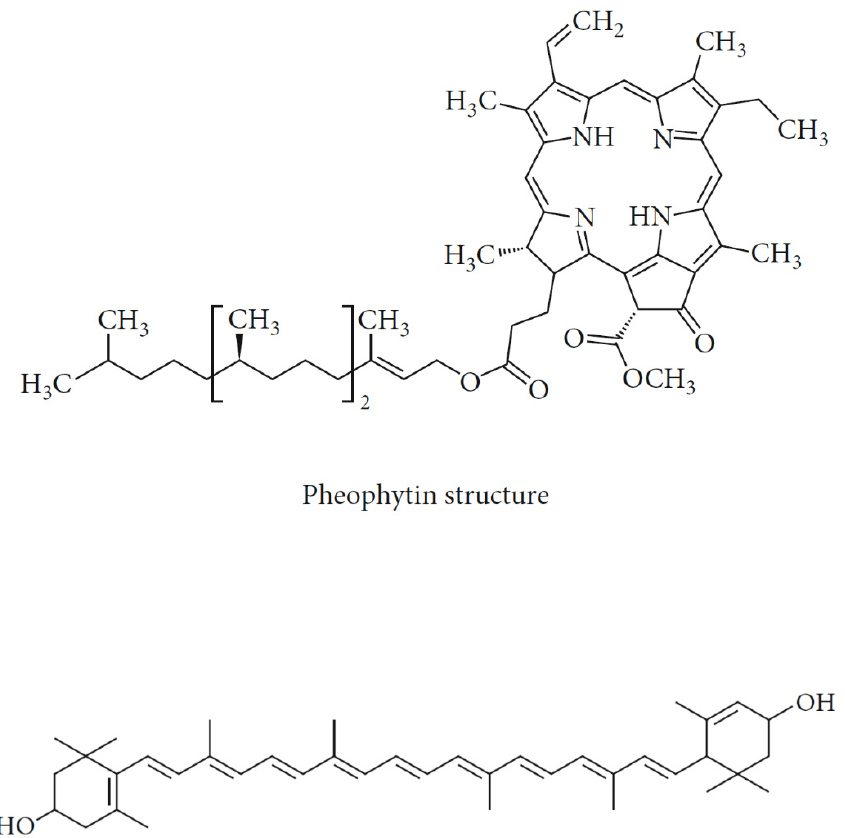
Figure 4. Chemical structures of pheophytin and lutein fractions in prickly pear seeds oil. Image from